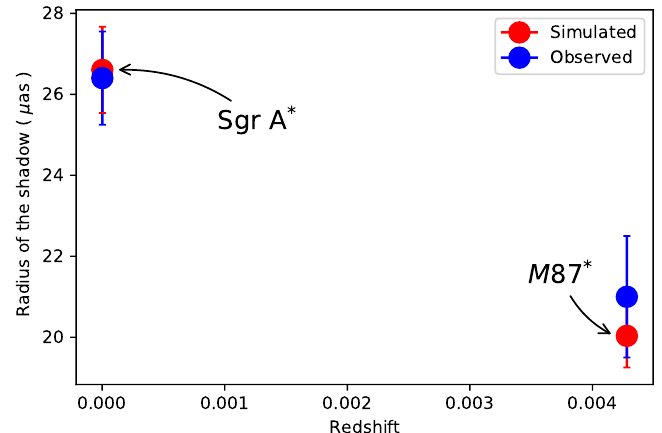
Figure 1. Comparison of the forecasted SMBH shadow radius (red color) from EHT observations M87* and Sgr A* (blue color). We consider a conservative fixed cosmology with H 0 = 73.8 km/s/Mpc, Ω = 0.262 to compare the observable radius α with its forecasted m 0